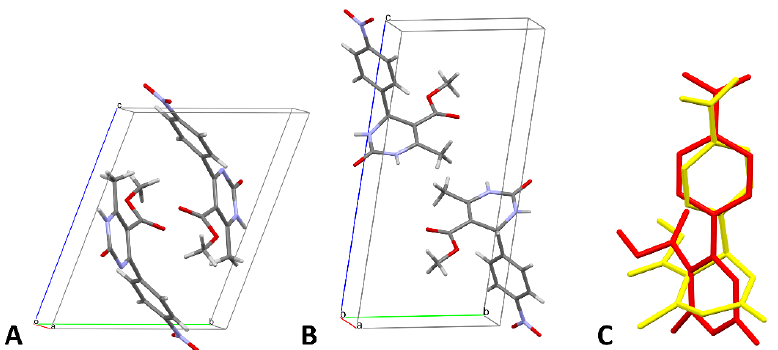
Figure 5. ( A .) Asymmetric unit of 2 . ( B .) Asymmetric unit of 1 , according to the crystal structure solved by Bairagi and co-workers [62]. ( C .) Overlay of 1 (yellow) and 2 (red). Hydrogens are omitted for the sake of clarity.